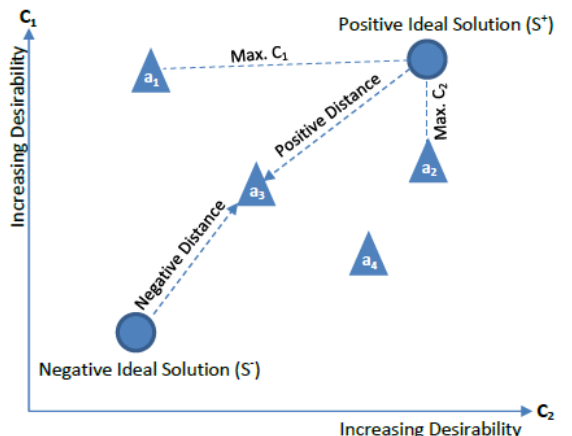
Fig. 1. Illustration of TOPSIS